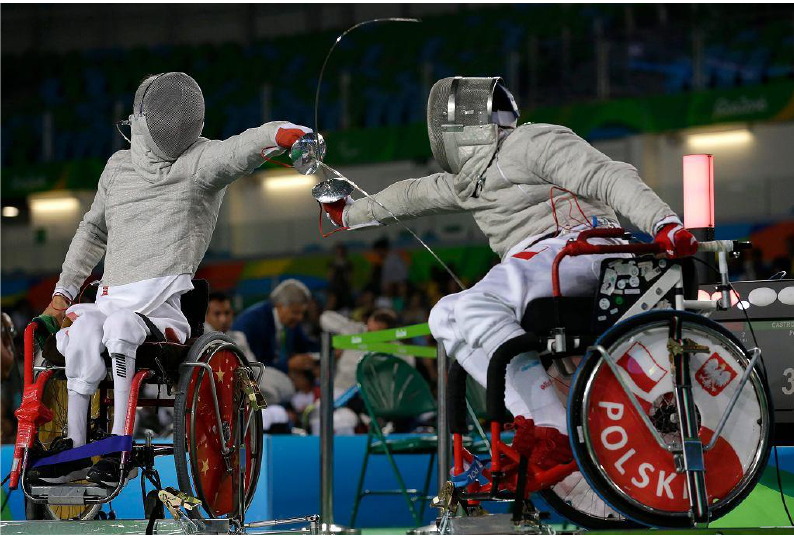
Figure 1. Wheelchair fencing medalist Paralympic Games.